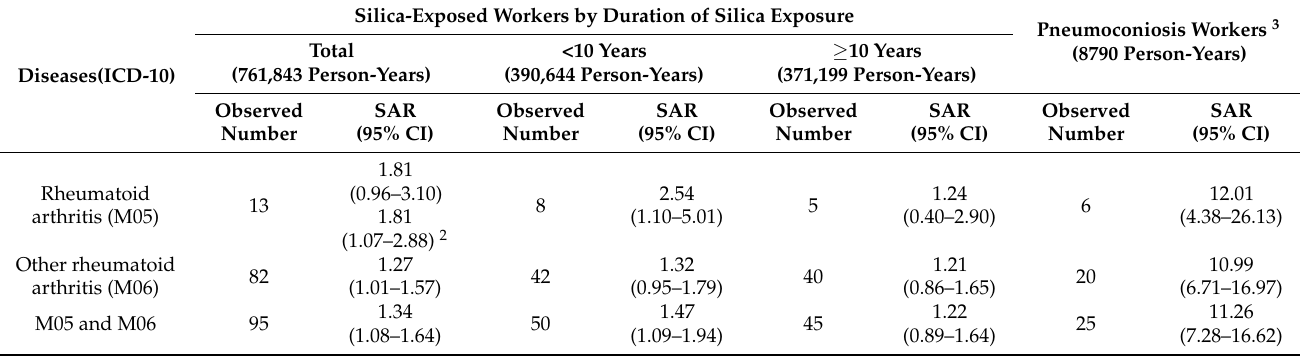
Table 2. Standardized admission ratios of silica-exposed and pneumoconiosis workers 1